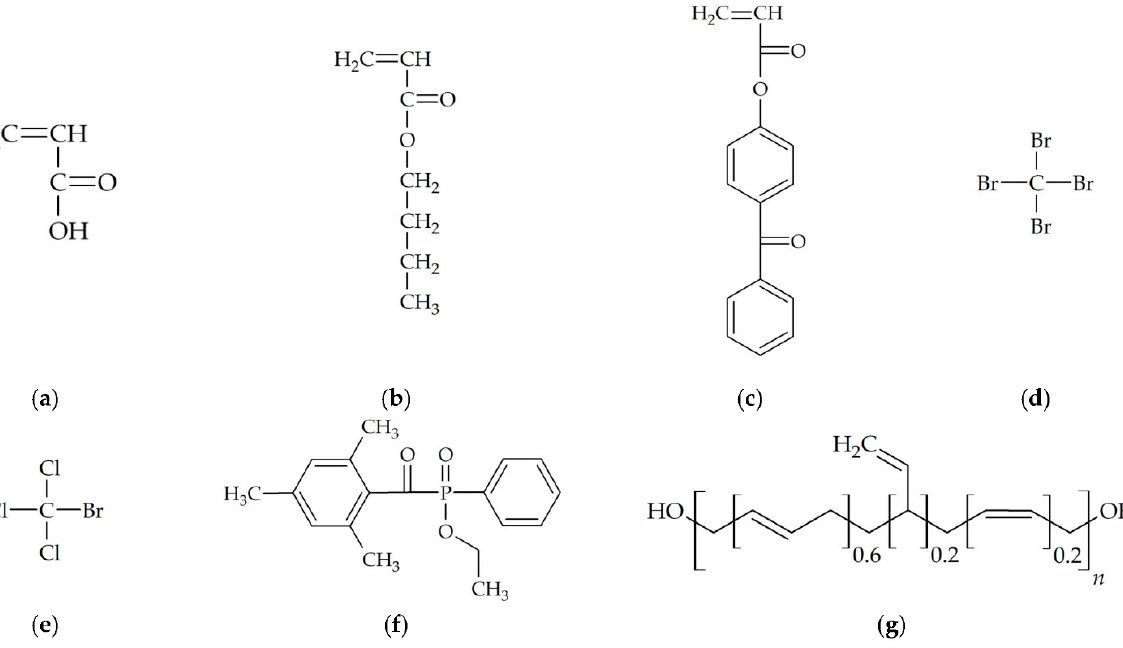
Figure 1. Chemical structures of the compounds: ( a ) acrylic acid, ( b ) n-butyl acrylate, ( c ) 4- acrylooxybenzophenone, ( d ) tetrabromomethane, ( e ) bromotrichloromethane, ( f ) TPOL radical photoinitiator (APO-type) ( g ) polybutadiene resin HTB.